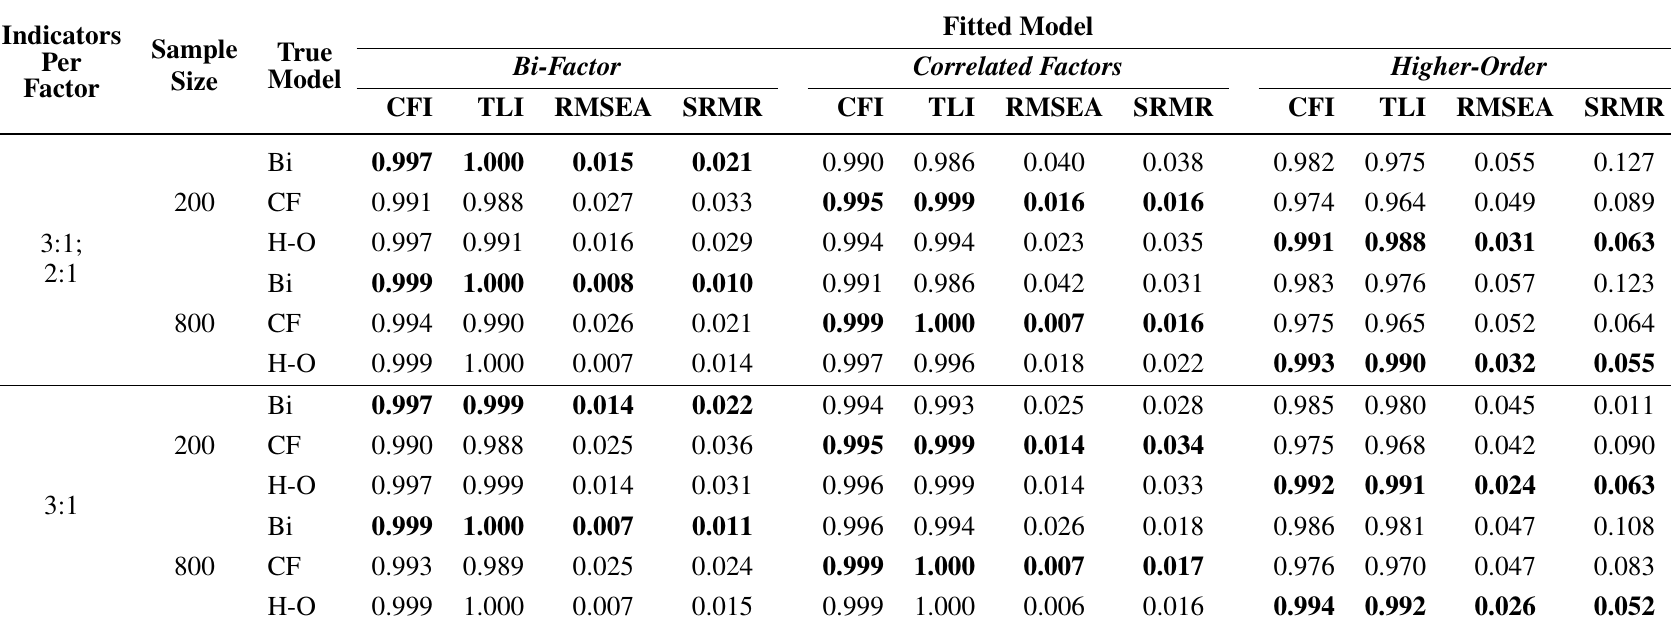
Table 1. Mean values for each approximate fit index for each cell of the study